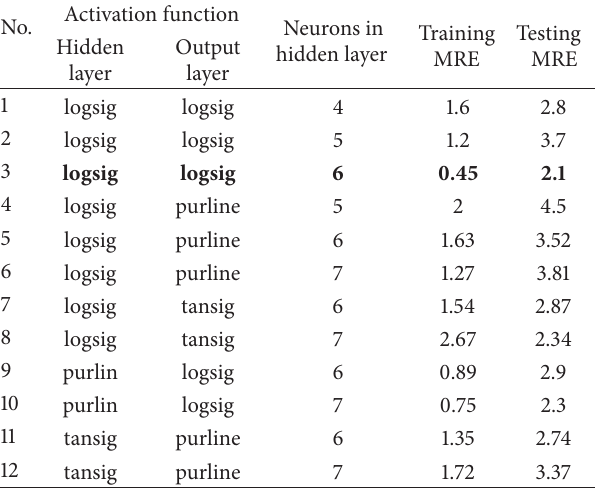
Table 2. The performance of each network was checked by MRE shown in the following